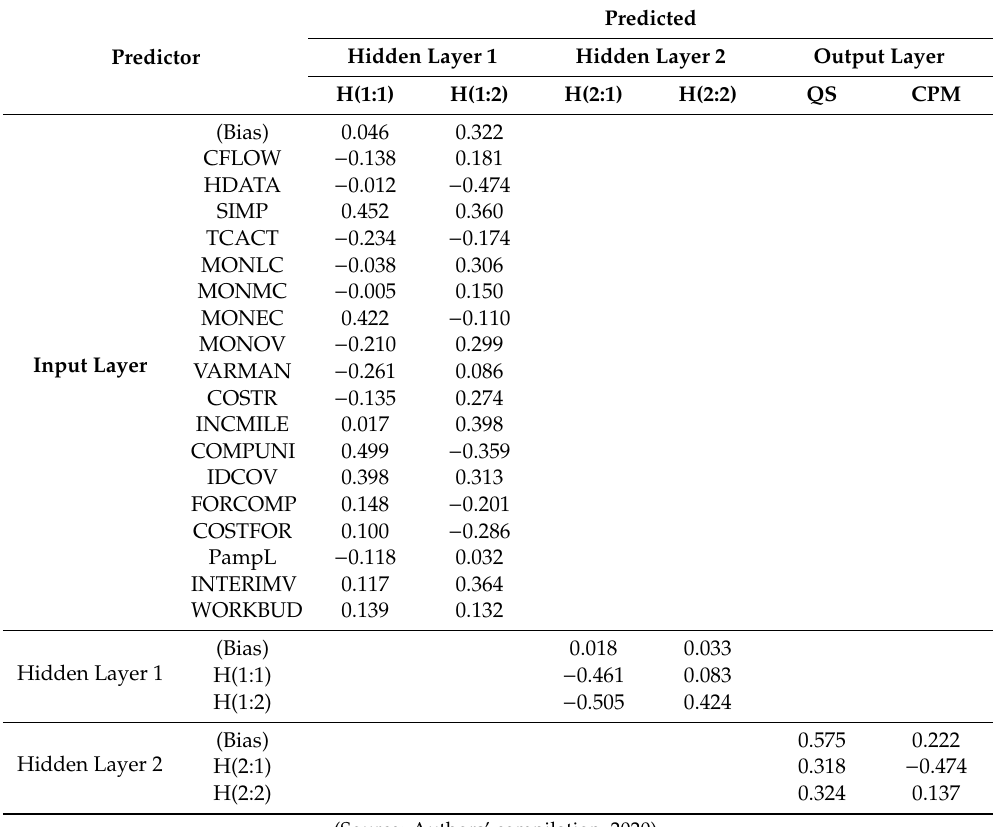
Table 8. Synaptic weights for normalised two hidden layers.